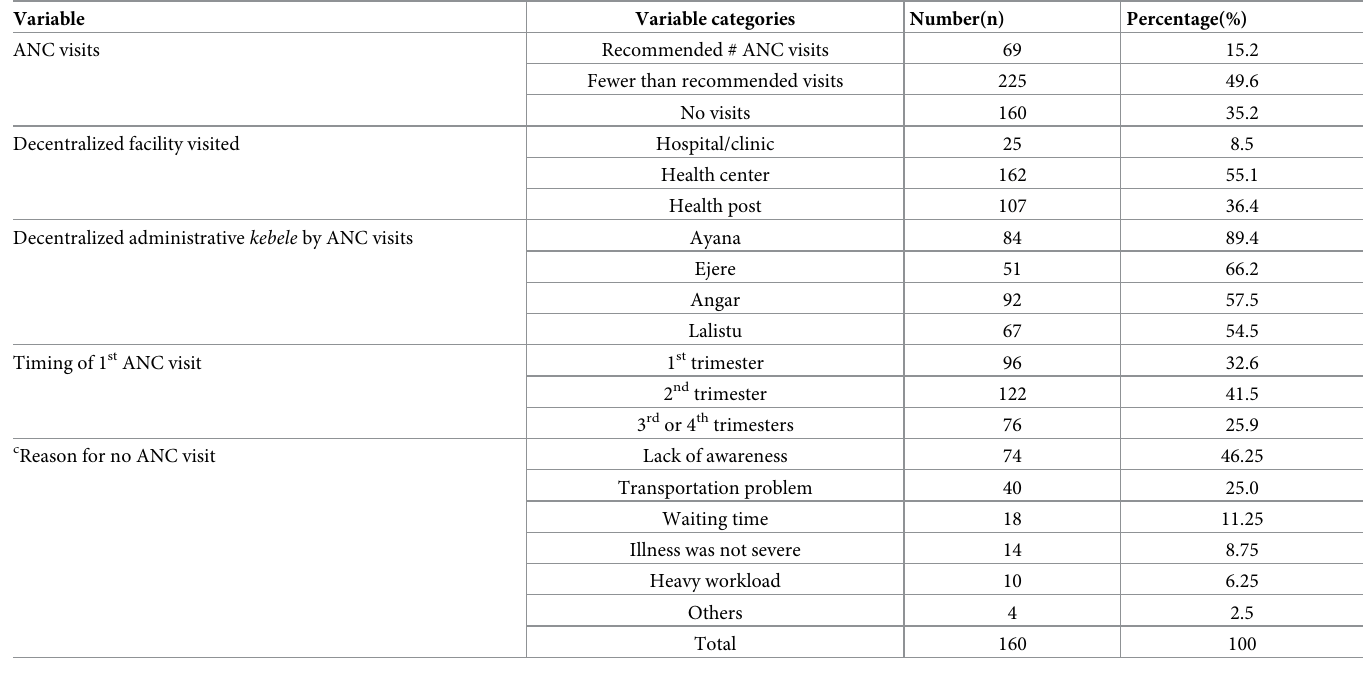
Table 2. Utilization of ANC and local health facilities attended, in Gida Ayana Woreda , rural western Ethiopia, Nov. 2016-Jan. 2017 ( N =